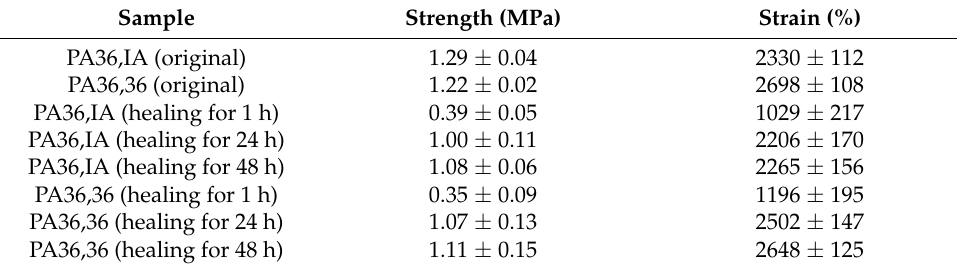
Table 3. Tensile properties of fully bio-based PA elastomers.